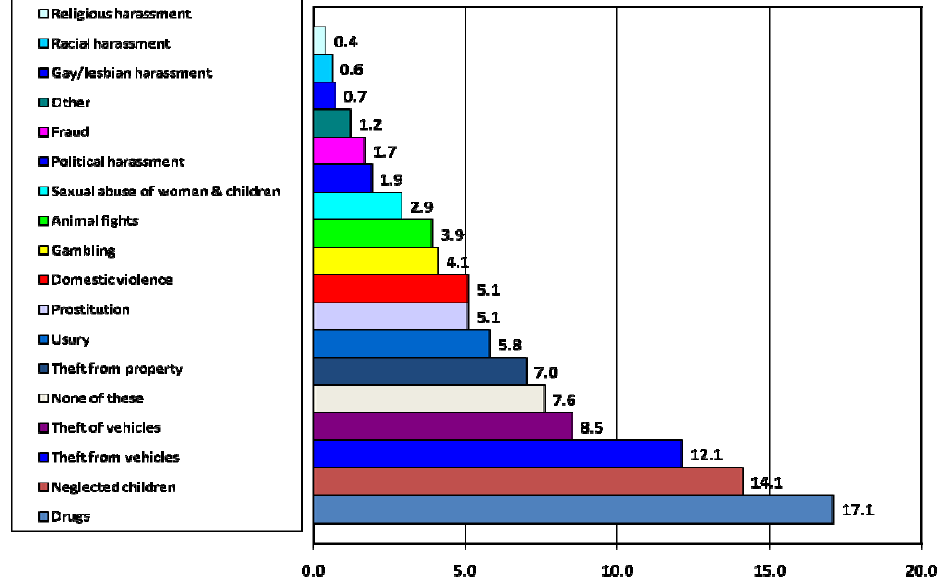
Figure 4. Criminal and antisocial behaviour in